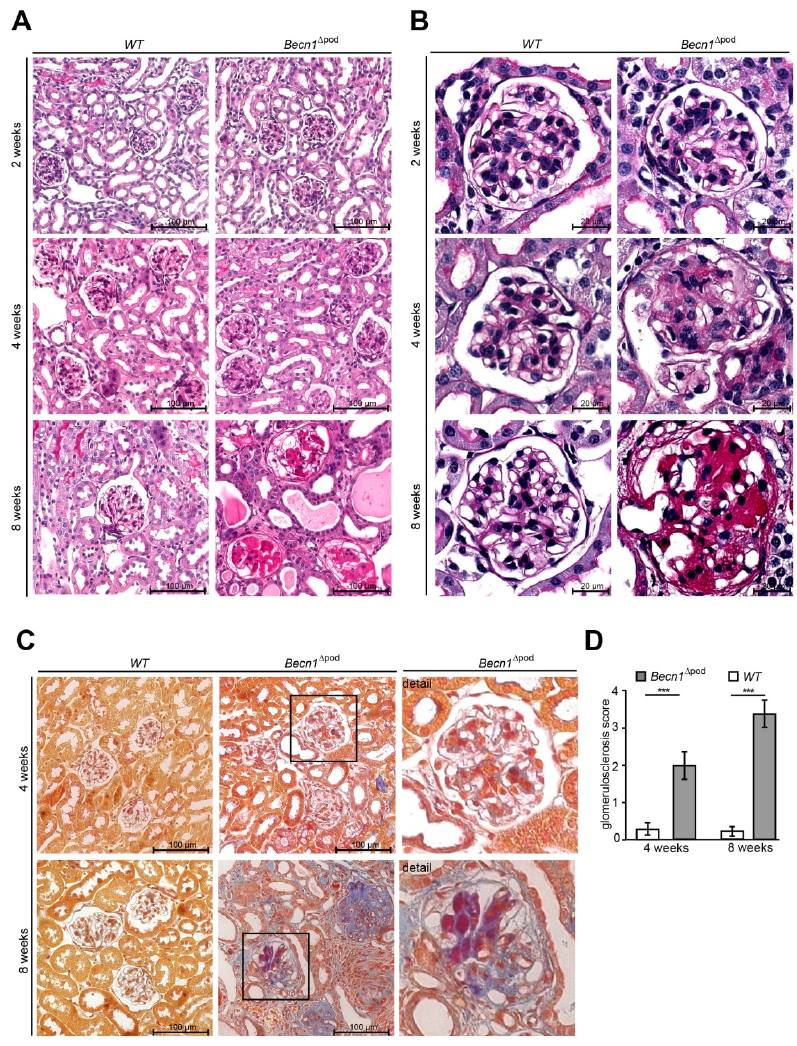
Figure 2. Podocyte-specific knockout of Becn1 leads to glomerular scarring. ( A ) Kidney sections obtained from 2-week-old, 4-week-old and 8-week-old WT and Becn1 Δ pod mice stained with haematoxylin-eosin solution; ( B ) Glomeruli from kidney sections obtained from 2-week-old, 4-week-old and 8-week-old WT and Becn1 Δ pod mice stained with haematoxylin-eosin solution; ( C ) Kidney sections and magnified glomeruli obtained from 4-week-old and 8-week-old WT and Becn1 Δ pod mice stained with acid-fuchsin, orange-G, and aniline blue solution; ( D ) Glomerulosclerosis score calculated using the method of el Nahas in 4-week-old and 8-week-old WT and Becn1 Δ pod mice (*** ≤ 0.001).